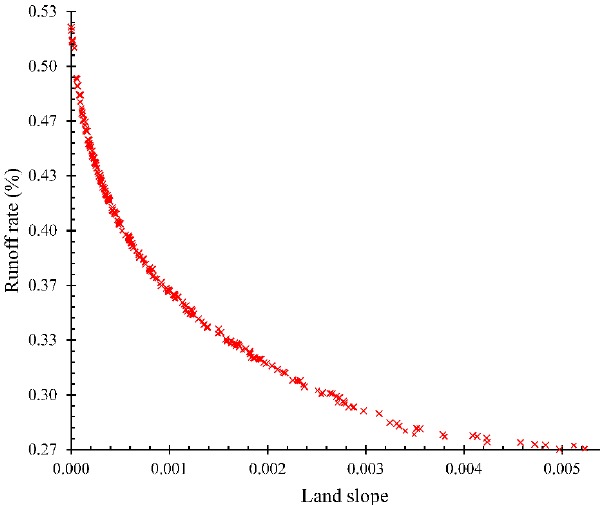
Figure 1. Optimal front of multi-objective planning.